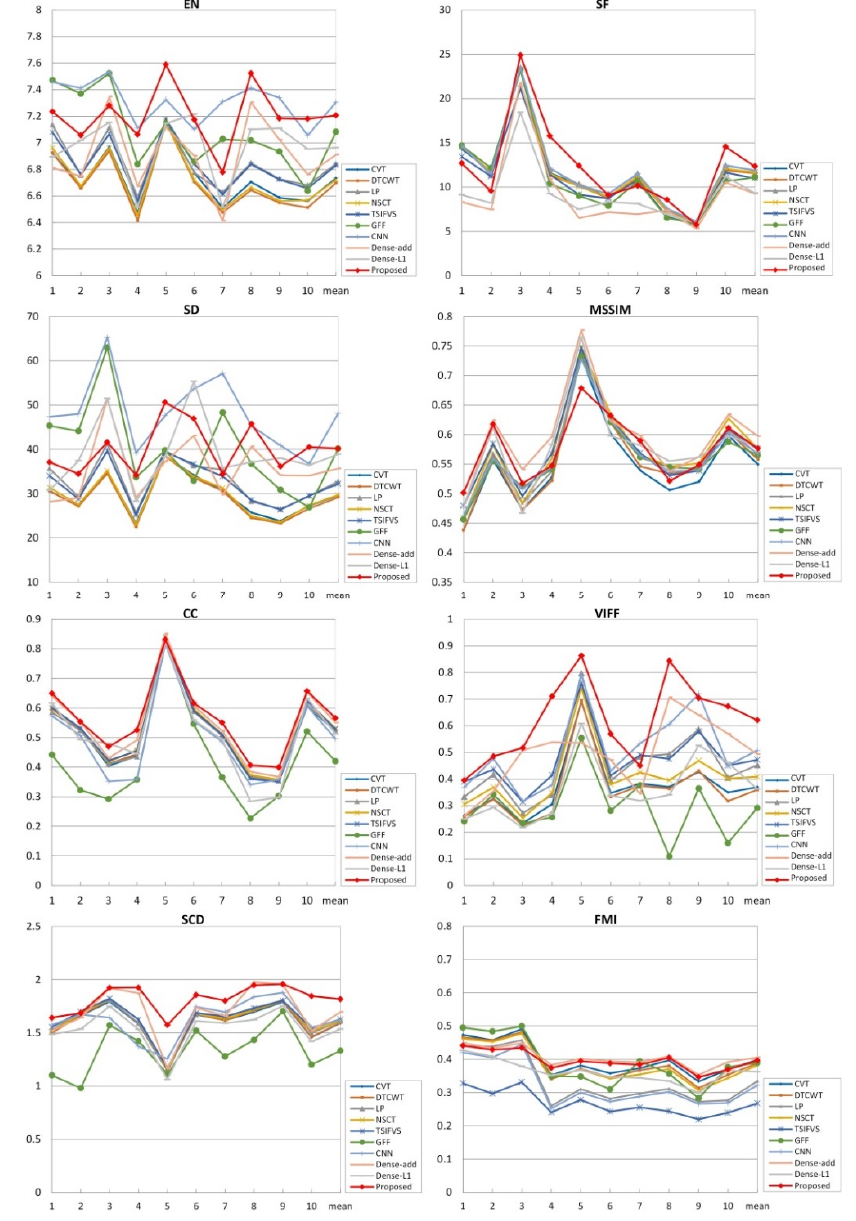
Figure 10. Quantitative values of eight metrics.